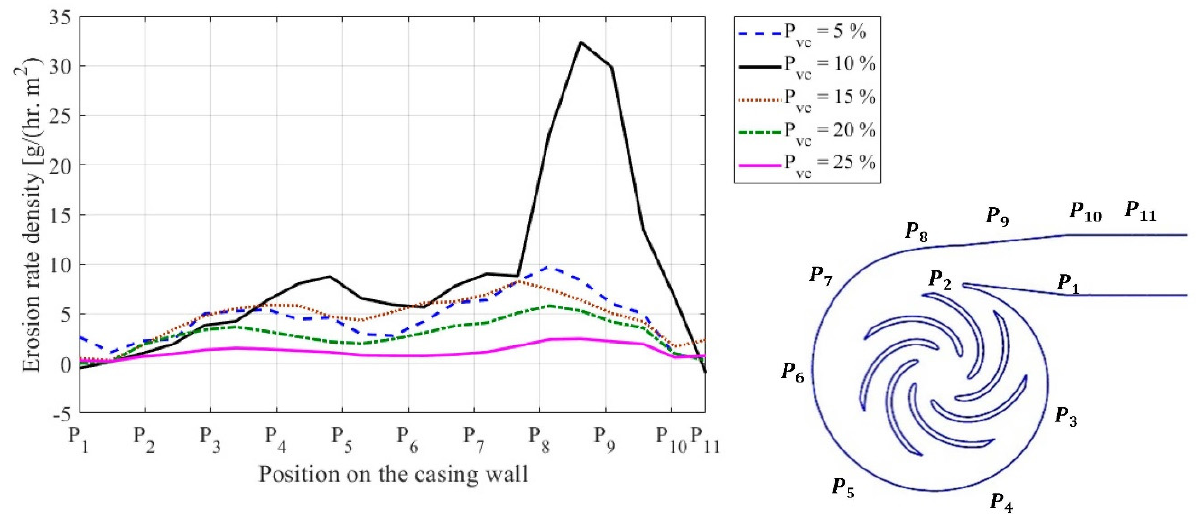
Figure 11. Variation of erosion rate density along the casing wall with different values volumetric concentration of the solid particles.